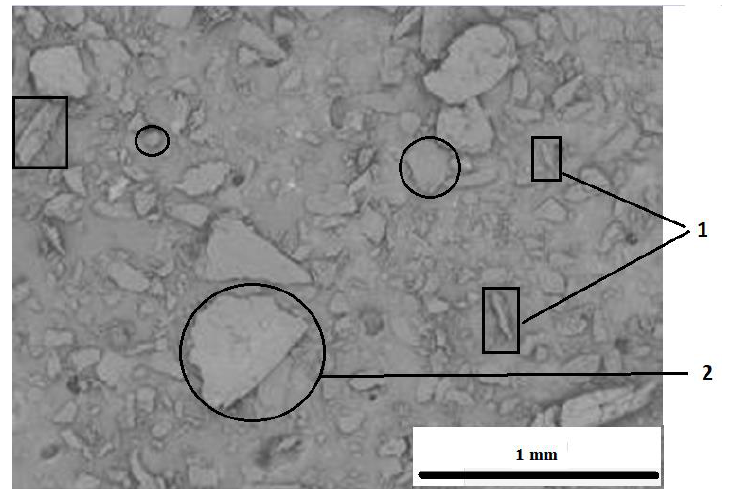
Figure 1. SEM image of residues from blackcurrant processing: examples of particles in the form of fibers (1), particles in the form of ovals and polygons marked with an oval (2). Figure 2 shows the BCP particle size distribution.